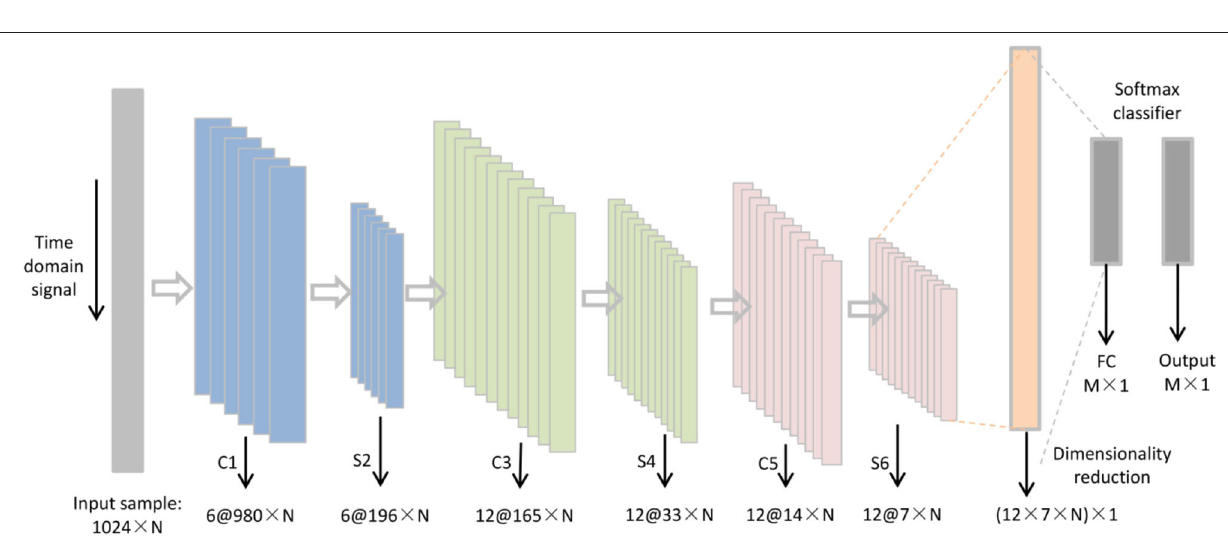
Frontiers in Materials |